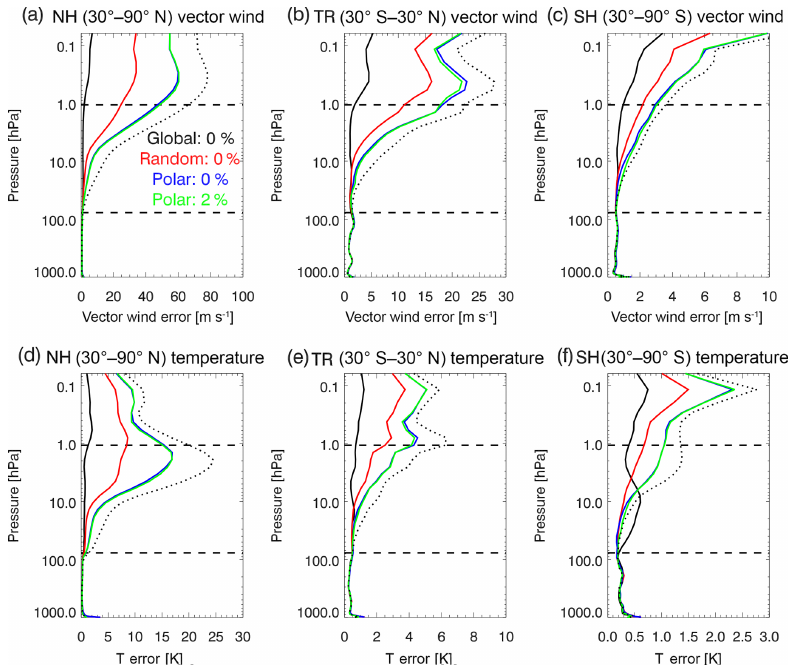
Figure 18. The rms vector wind errors (ms − 1 ) averaged from 25 November to 1 December 2014 for (a) NH, (b) TR, and (c) SH and rms temperature errors (K) for the (d) NH, (e) TR, and (f) SH. Solid lines are for ozone assimilation experiments for global: 0% error (black), random: 0% error (red), polar: 0% error (blue), and polar: 2% error (green). Dotted line is the background for the ozone assimilation experiments. Horizontal dashed lines indicate vertical range of assimilated stratospheric ozone observations. Note that the ranges of the horizontal axes for each panel vary based on maximum baseline errors. See Table 1, Sect. 4.3 and